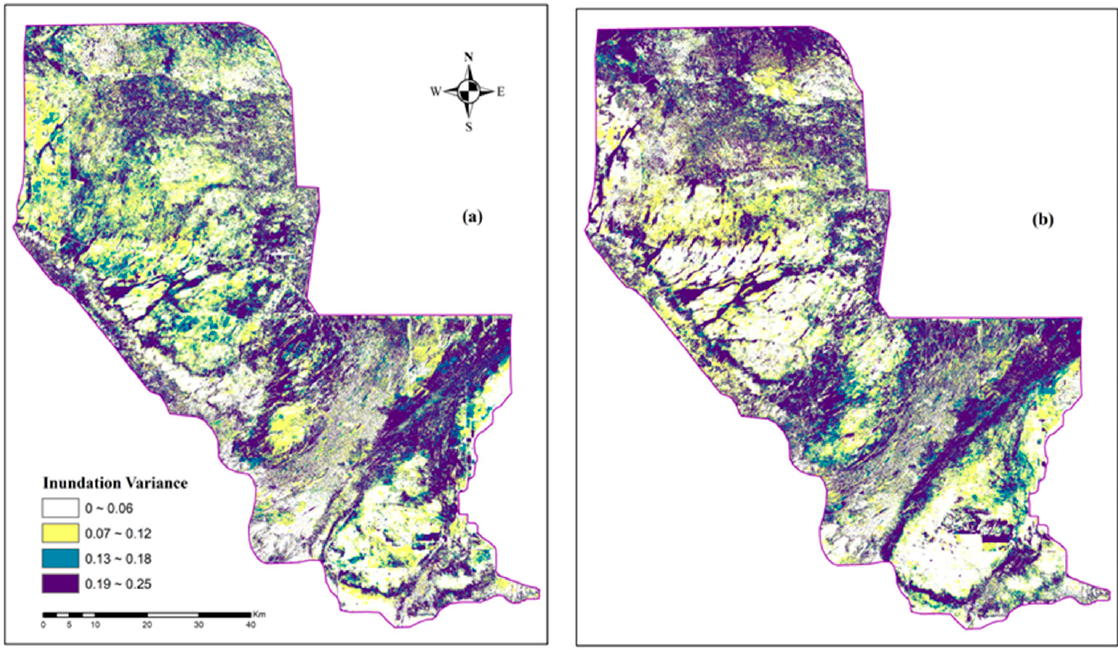
Figure 6. Twenty years of inundation variances during ( a ) wet season and ( b ) dry season from 2002 to